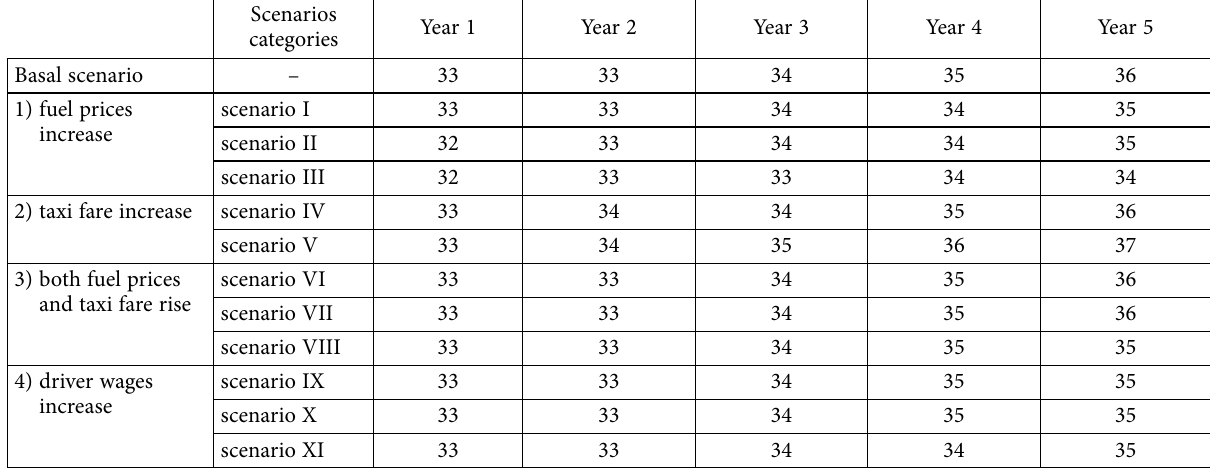
Table A2. The statistics of daily service trips per taxi for taxi operation simulation